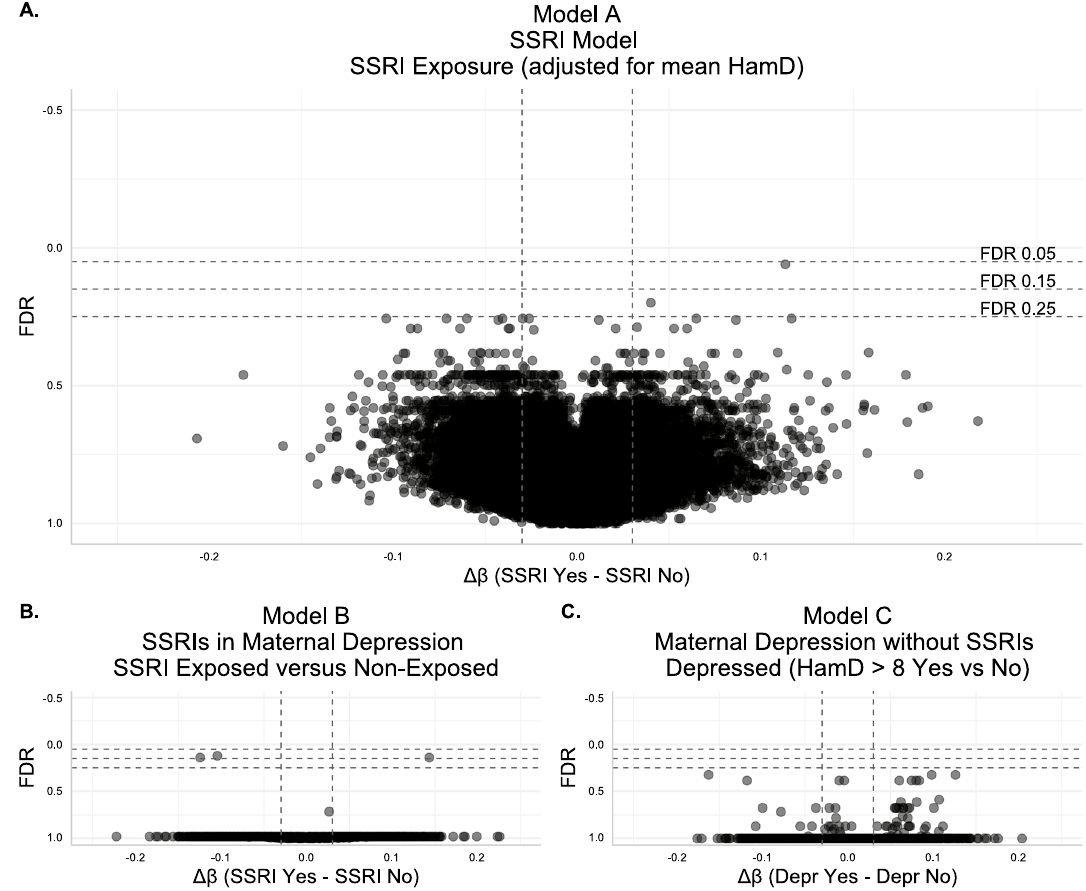
Figure 2. Volcano plots for differential DNAme in association with SSRI exposure and categorical depression. For all plots HamD refers to the mean maternal Hamilton Depression score across gestation for each individual. False discovery rate (FDR) is shown along the Y axis with more significant (lower FDR) values at the top of the plot. Vertical dashed intercepts demarcate |Δβ| = 0.03, horizontal dashed intercepts indicate, from top to bottom, FDR = 0.05, FDR = 0.15, and FDR = 0.25. ( A ) Volcano plot for the SSRI model, investigating differential DNAme associated with SSRI exposure adjusted for mean maternal HamD score, (n = 64). Difference in DNAme (Δβ) is plotted along the X axis and was calculated as Δβ = β SSRI-exposed – β SSRI non-exposed . ( B ) Volcano plot for the SSRIs in maternal depression model, differential DNAme associated with SSRI exposure in cases with mean maternal HamD score > 8, (n = 34). Difference in DNAme (Δβ) is plotted along the X axis and was calculated as Δβ = β SSRI-exposed – β SSRI non-exposed . ( C ) Volcano plot for the maternal depression without SSRIs model, differential DNAme associated HamD score > 8 across gestation, in SSRI non-exposed cases, (n = 44). Difference in DNAme (Δβ) is plotted along the X axis and was calculated as Δβ = β Hamilton > 8 – β Hamilton ≤ 8 , “Depr” indicates “Depressed”, i.e. HamD > of + 0.11 (higher average DNAme β value in SSRI-exposed placentas). Loosening the threshold to FDR < 0.25, one additional CpG was differentially methylated by SSRI exposure status (cg20877313), and was also more highly methylated in SSRI-exposed placentas (Δβ = + 0.04). In the SSRIs in maternal depression model (model B), three CpGs were differentially methylated at the moderate-confidence threshold of FDR < 0.15 (cg12655501, cg26993610, cg14340829). These CpGs all had an average difference in DNAme between SSRI-exposed and SSRI non-exposed cases of |Δβ| > 0.10. In the maternal depression without SSRIs model (model C), no CpGs showed evidence of maternal depression-associated differential DNAme at any FDR threshold. For a description of all CpGs that satisfied the moderate and low-confidence FDR thresholds from the SSRI models (A, B) and SSRIs in maternal depression model (C), including test statistics and overlapping genes, see Table 3. Summary statistics of linear modelling from all CpGs tested are presented in Supplementary Tables S2–S4. Boxplots showing aver- age DNAme β values in SSRI-exposed versus SSRI non-exposed cases for the differentially methylated CpGs are shown in Fig. 3. A differentially methylated region (DMR) analysis was also conducted, to increase power for discovering DNAme-associations by grouping signatures from multiple neighboring CpG sites to reduce the number of statistical comparisons. DMR analysis was only conducted for the SSRI model to enable utilization of the entire cohort of cases and maximize statistical power.